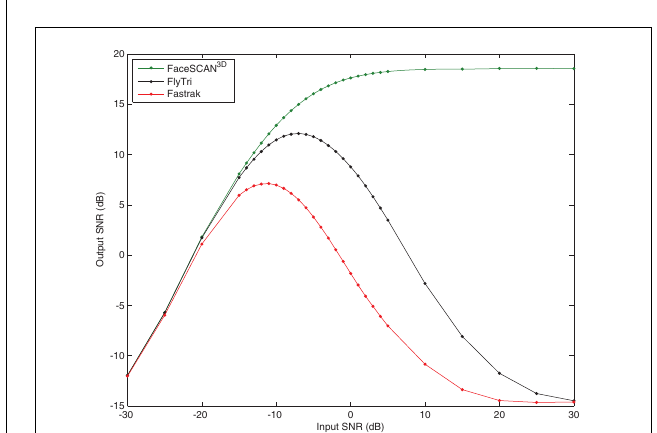
FIGURE 5 | The mean beamformer output SNR averaged over all simulated source locations as a function of input SNR. The output SNR from fringe projection (i.e., the same electrode coordinates from which the simulation was generated) increases with input SNR, reaching an asymptotic limit of approximately 18.6dB. When reconstructing with FlyTri and Fastrak coordinates (i.e., with electrode position measurement errors), output SNR improves to a point but then falls with further increases of input SNR. Nevertheless, the FlyTri coordinates outperform the Fastrak coordinates by several decibels, above an input SNR of approximately −